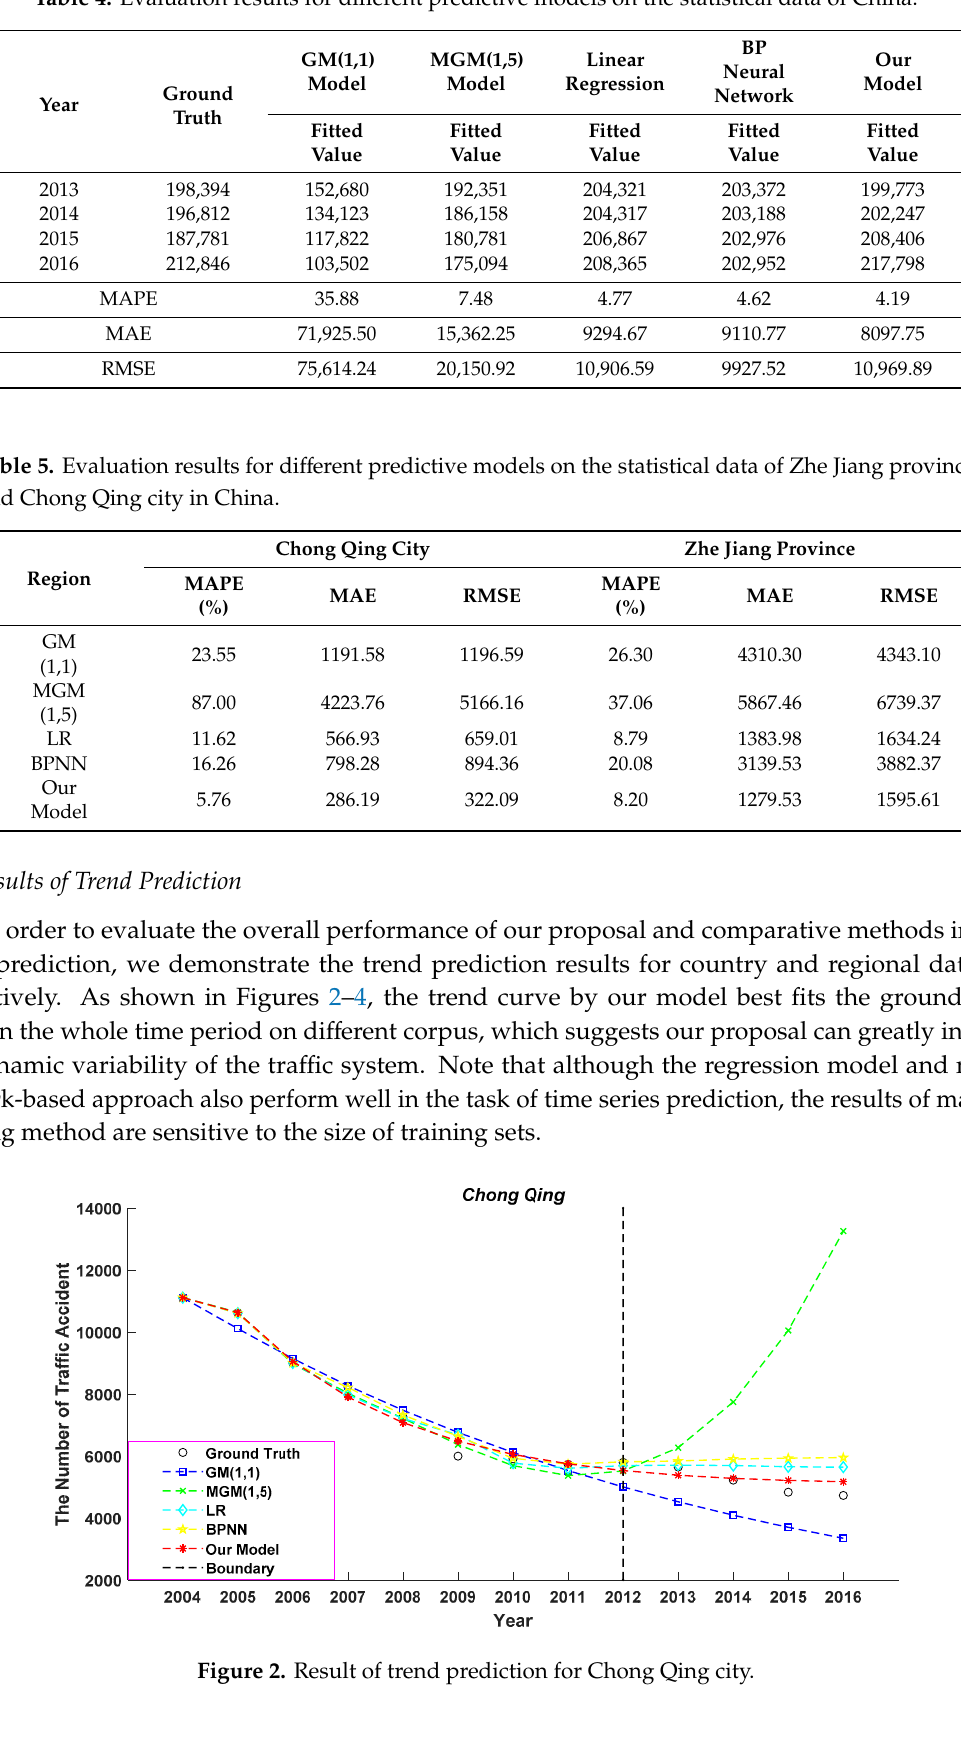
Figure 3. Result of trend prediction for Zhe Jiang province. Figure 4. Result of trend prediction for the country of China.